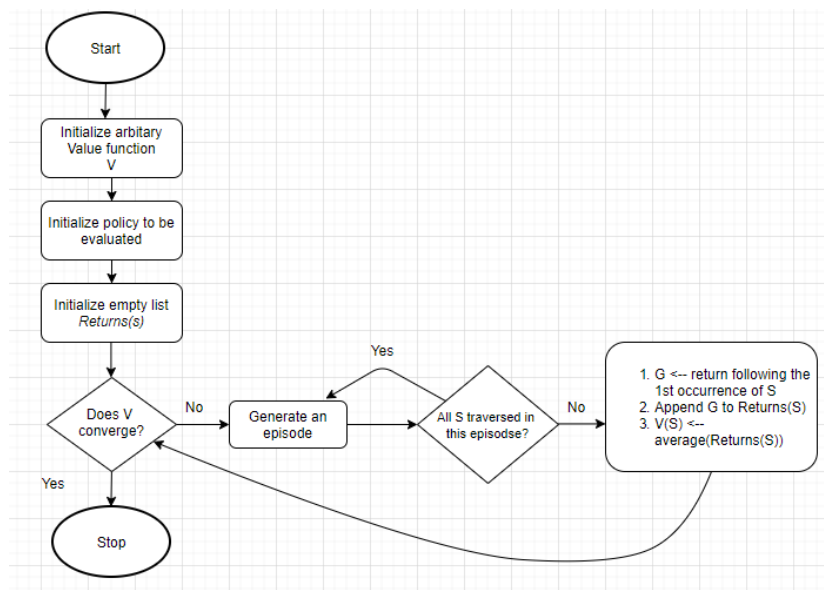
Figure 1. Steps of Monte-Carlo prediction in the context of reinforcement